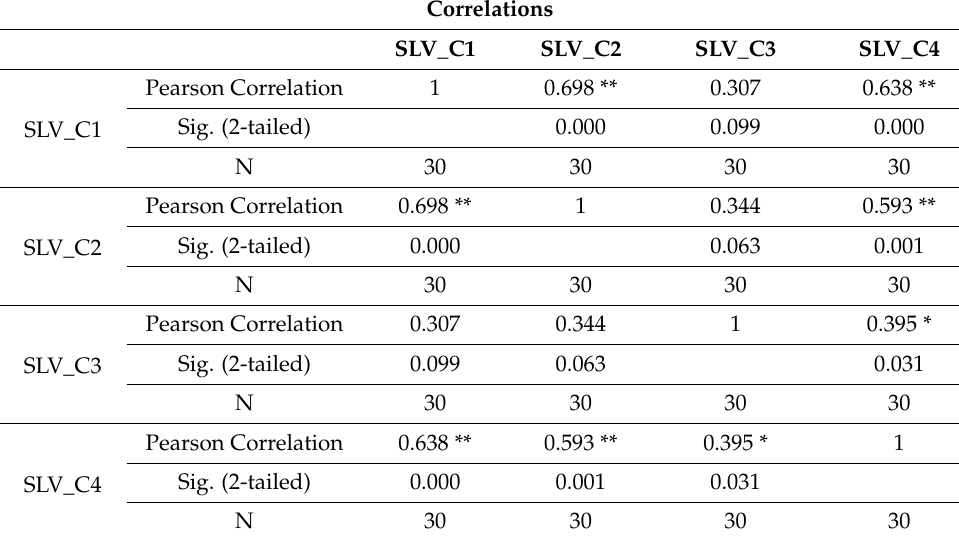
Table 9. Correlation test on stop line